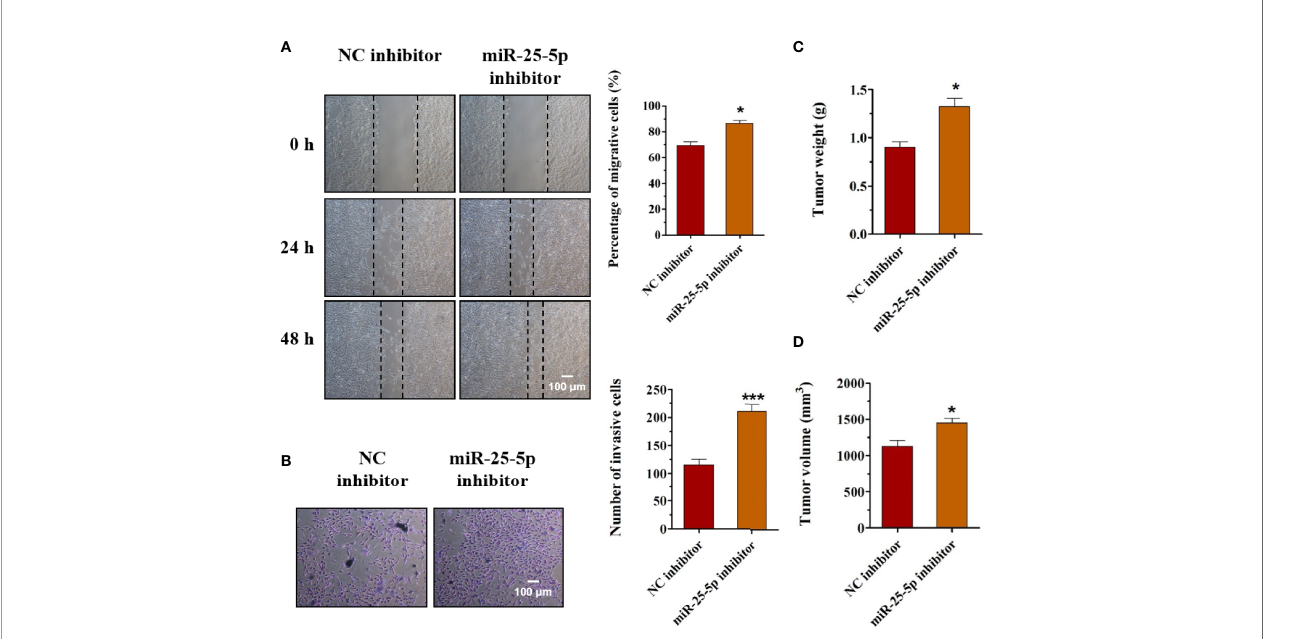
FIGURE 6 | Knockdown of miR-25-5p accelerates the migration, invasion, and tumor formation of OSCC cells. (A, B) The effects of miR-25-5p inhibitor on the migration and invasion of SCC9 cells were detected by wound healing assay and transwell invasion assay, respectively (n=4). (C, D) The SCC9 cells transfected with miR-25-5p inhibitor or NC inhibitor were injected subcutaneously into the fl anks of the nude mice. After 4 weeks, the tumor nodules were collected and the tumor formation was examined (n=10). (Student ’ s t-test, *p < 0.05 and ***p < 0.001, Scale bar, 100 m m).